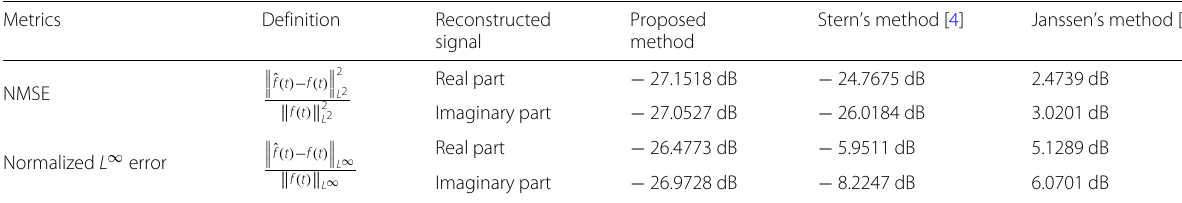
Proposed Stern’s method [4] signal method